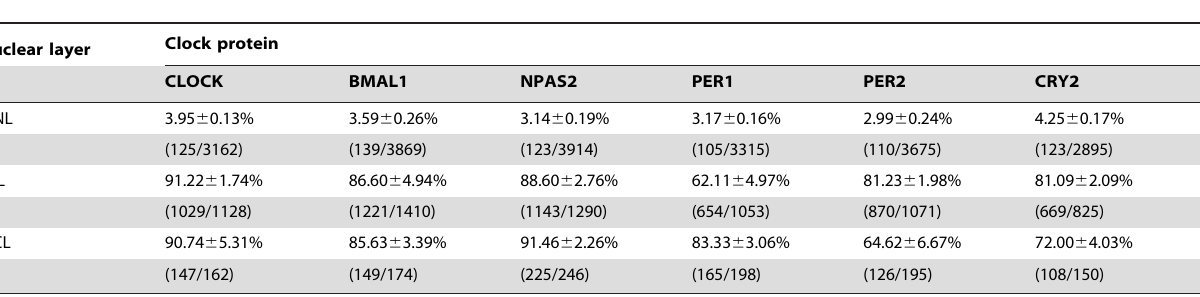
Retinas were collected around ZT02 during a LD cycle. Cells were identified by DAPI staining of their nucleus. Significant clock protein expression was defined as fluorescent level higher than 150% background. The number of positive cells/total number of cells counted is indicated between parentheses. Data shown are averaged values from 3–5 animals (3 pictures from 3 different sections per animal) 6 SEM.